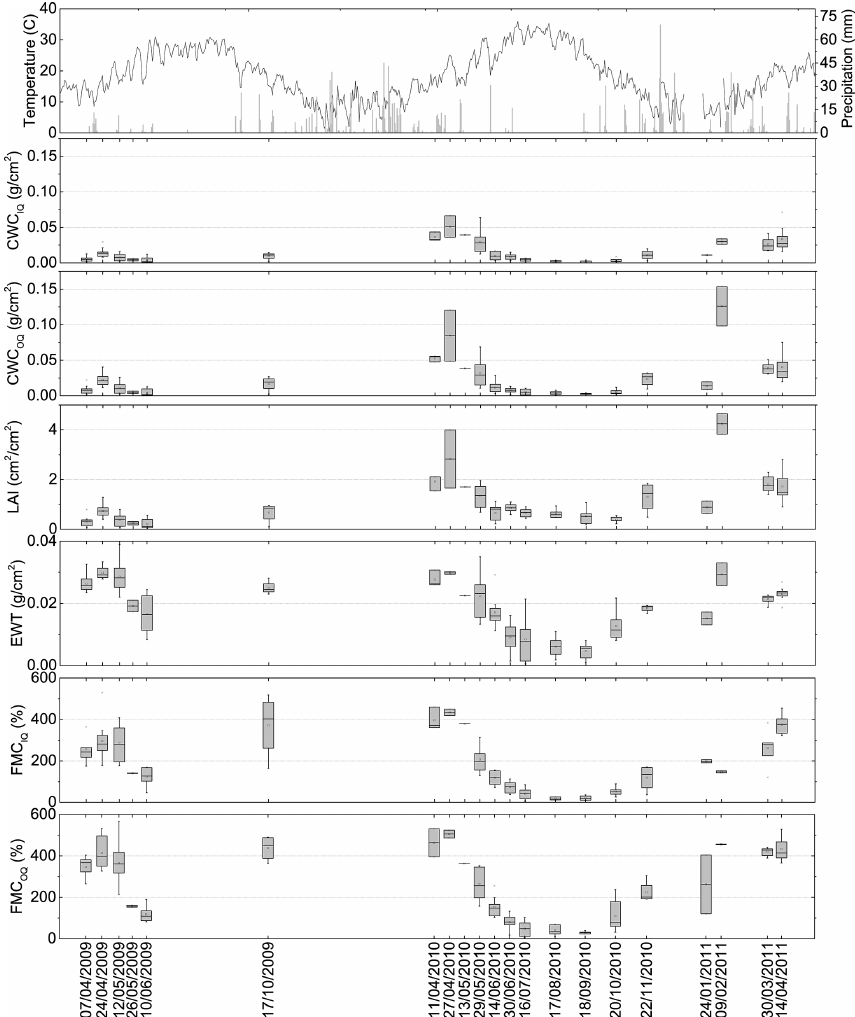
Figure 3. Box plot showing the temporal evolution of field biophysical variables measured. Filled points represent the median of the daily measurements, the boxes indicate the position of the 1st and 3rd quartile, lines delimit the maximum and minimum values. Line inside the boxes showed the median value of the day and the point the mean value. Precipitation is represented using bars and temperature is represented with a solid